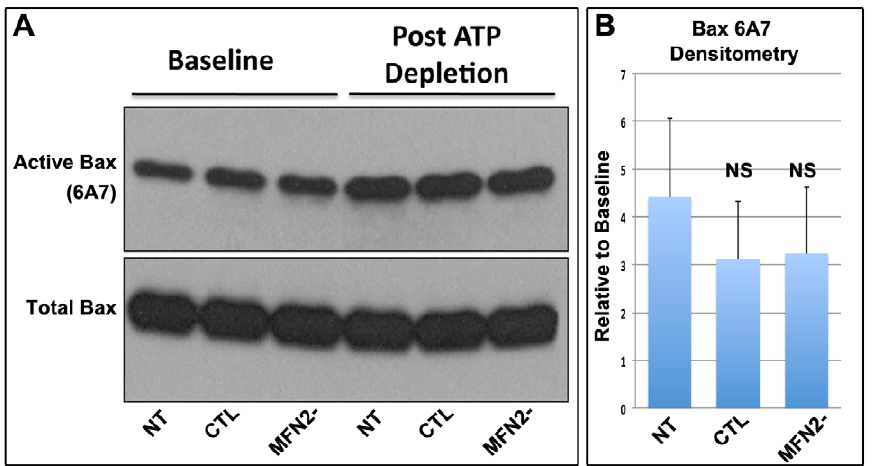
Figure 8. Effect of MFN2 deficiency on Bax activation. ( A ) Immunoblot of active Bax ( upper panel ) detected with an anti-6A7 epitope-specific antibody in MFN2 f/f proximal tubule epithelial lysates of cells transduced with no virus ( NT ), empty adenovirus ( CTL ) or Cre adenovirus ( MFN2- ) at baseline and 30 min after ATP depletion; total Bax controls are show for sample loading (lower panel) ; and ( B ) densitometric analysis of the relative increase in active 6A7-Bax content after metabolic stress.